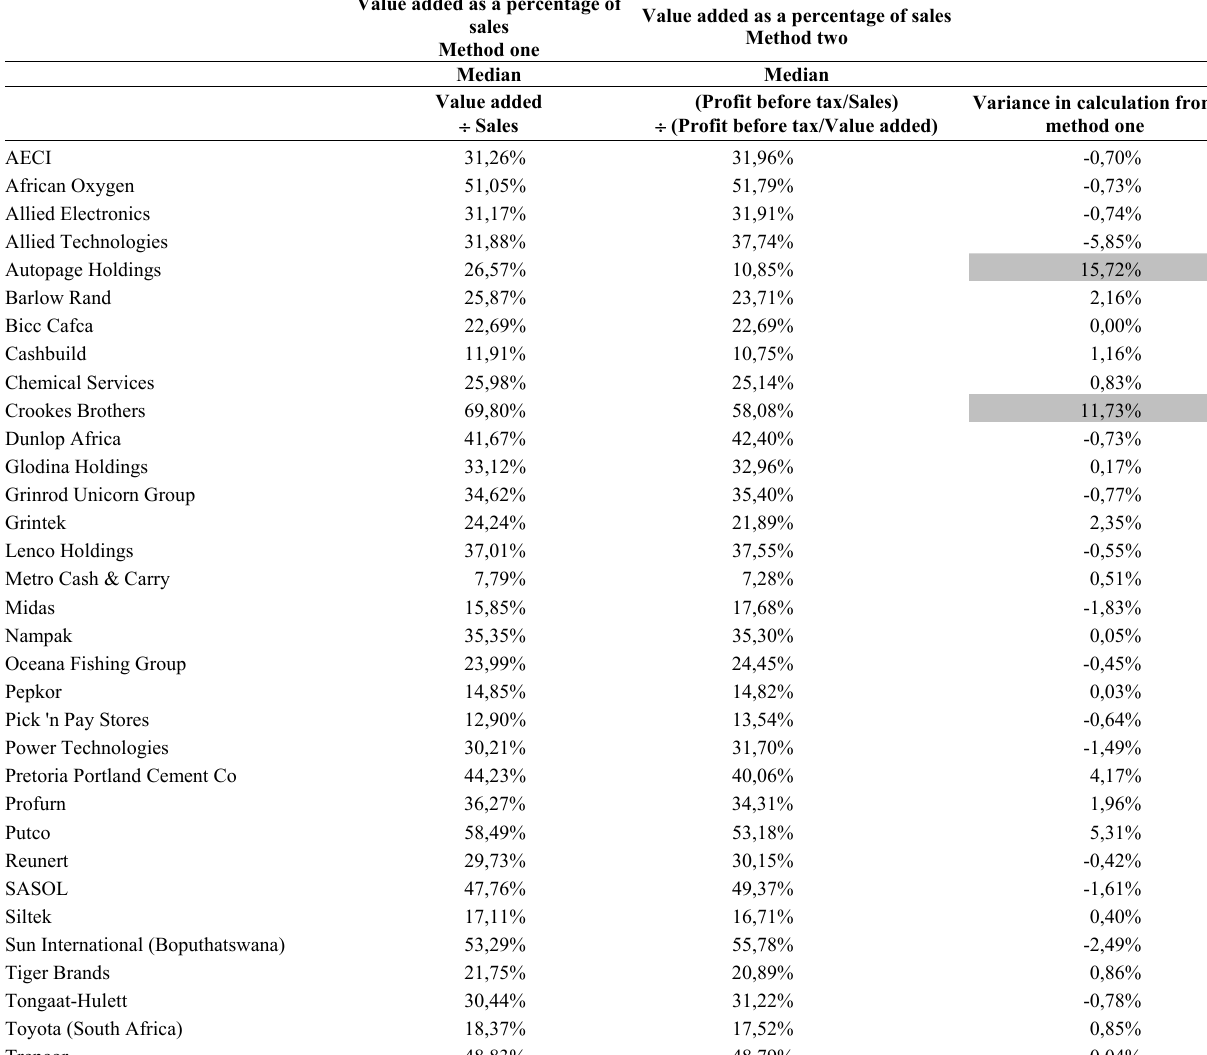
Figure 3: Overall business control per organisation: median Table 9: Two methods to calculate value added as a percentage of